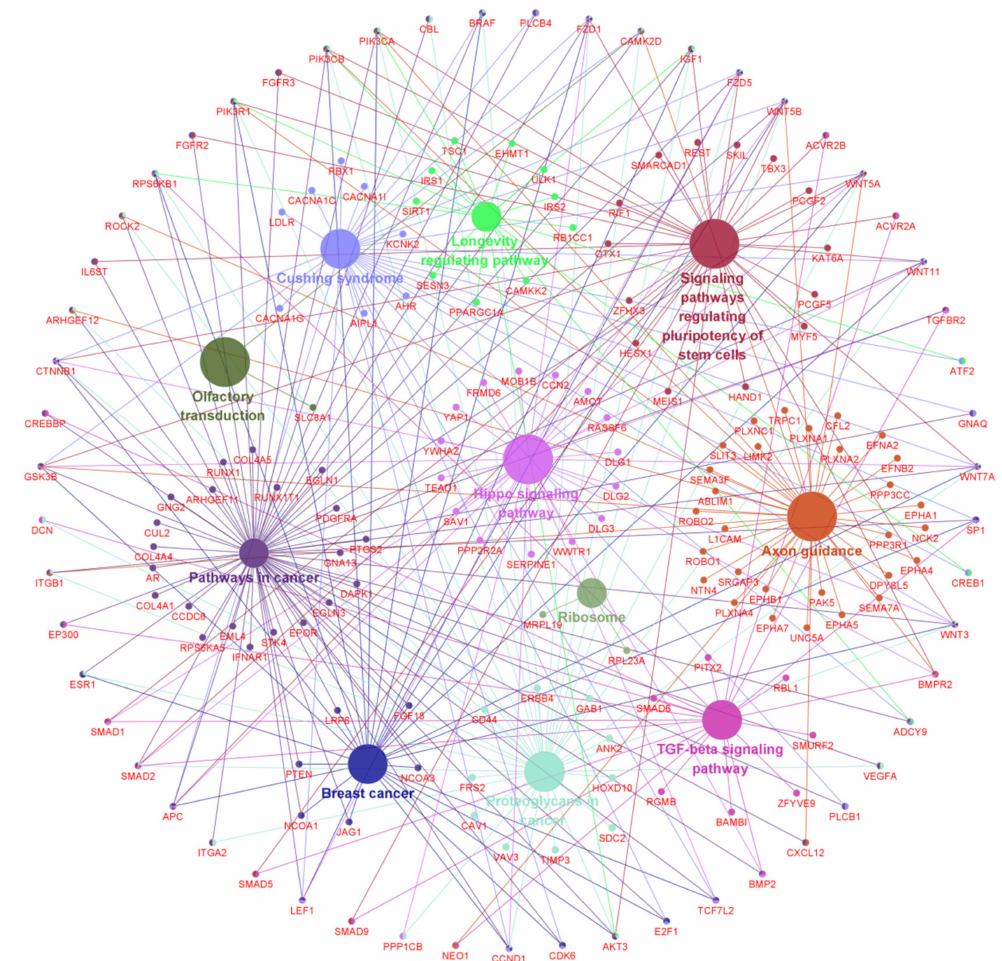
Figure 6. Pathway enrichment for the ceRNA regulatory genes of the six putative m 6 A-circRNAs with higher expression in anagen skin tissue of cashmere goats in comparison to telogen. The pathway enrichment was conducted using the CluePedia (a built-in plugin in Cytoscape procedure (http: //www.ici.upmc.fr/cluepedia/, 12 October 2021). the enriched pathways and their corresponding genes were visualized with the same color